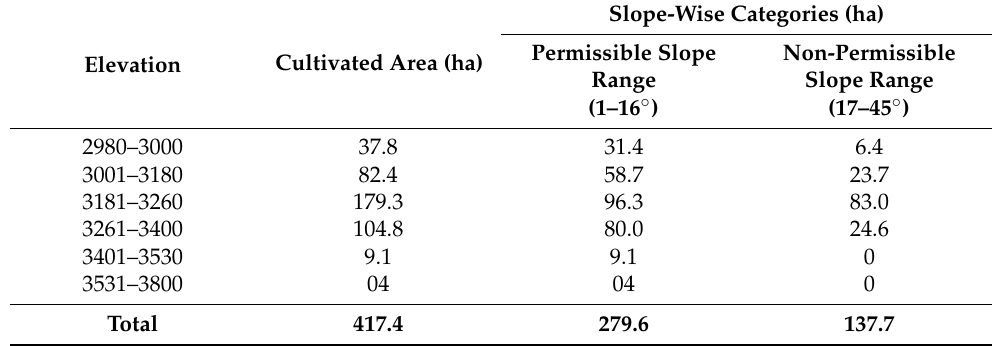
Figure 6. Cultivation on hillside steep slopes without soil conservation measures. Crop encroachment toward marginal hillside slopes was mainly complemented by the fact that intensive cultivation at the bottomland has deteriorated soil fertility, and in- creased the demand for agrochemical inputs and hybrid seeds. Consequently, this has